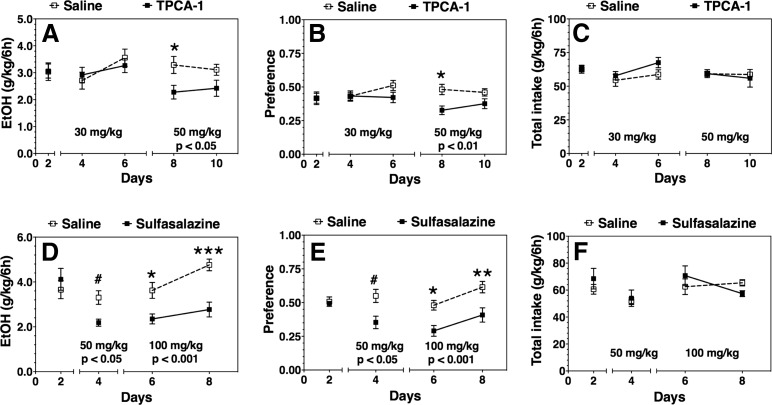
Effect of systemic administration of IKKβ inhibitors on ethanol (EtOH) intake and preference after 6 h of a continuous 24 h two-bottle choice test in C57BL/6J mice. A–C, TPCA-1 (30 and 50 mg/kg) vs saline treated (n = 13 per group). D–F, Sulfasalazine (50 and 100 mg/kg) vs saline treated (n = 6 per group). A, D, 15% ethanol consumption (g/kg/6 h). B, E, Preference for ethanol. C, F, Total fluid intake (g/kg/6 h). Day 2 in each panel shows the averages of 2 d of saline injections for each group ± SEM. Remaining time points are the 2 d drinking averages in the presence of saline or drug ± SEM. Significant main effect of drug treatment is shown by the p value beneath the treatment dose (two-way ANOVA with repeated measures). Significant post hoc effect of each drug compared with the corresponding saline group is indicated by the symbols above each time point (Bonferroni test for multiple comparisons, *p < 0.05, **p < 0.01, ***p < 0.001; or Student’s t test, #p < 0.05).